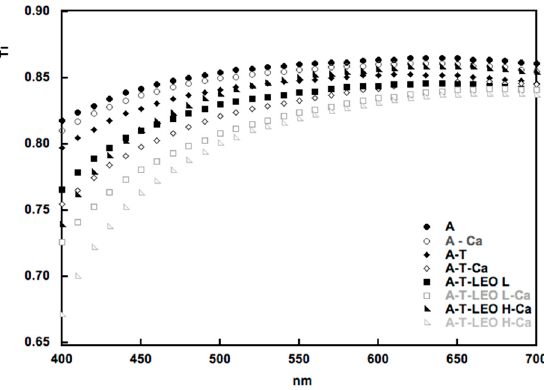
Figure 5. Spectral distribution of internal transmittance (Ti) of films with and without calcium chloride.